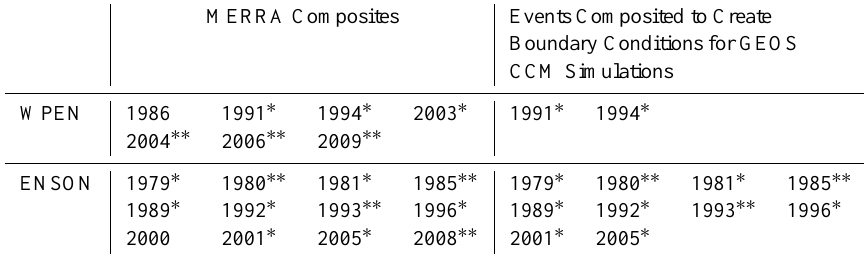
Table 1. List of ENSO events composited to create the SST and sea ice boundary conditions for the WPEN and ENSON simulations. The years shown refer to the SON season included for each event. ∗ symbols denote QBO-E years; ∗∗ symbols denote QBO-W years. MERRA Composites Events Composited to Create Boundary Conditions for